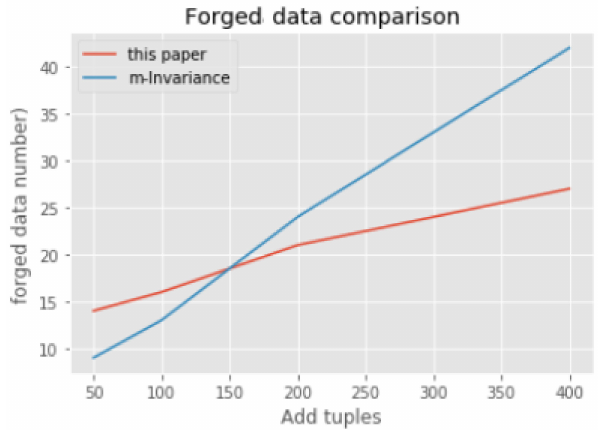
Figure 3. Forged data